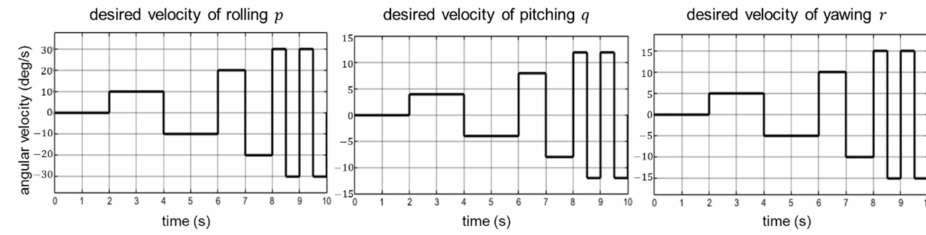
Figure 2. Block diagram of underwater vehicle’s attitude and position control system.